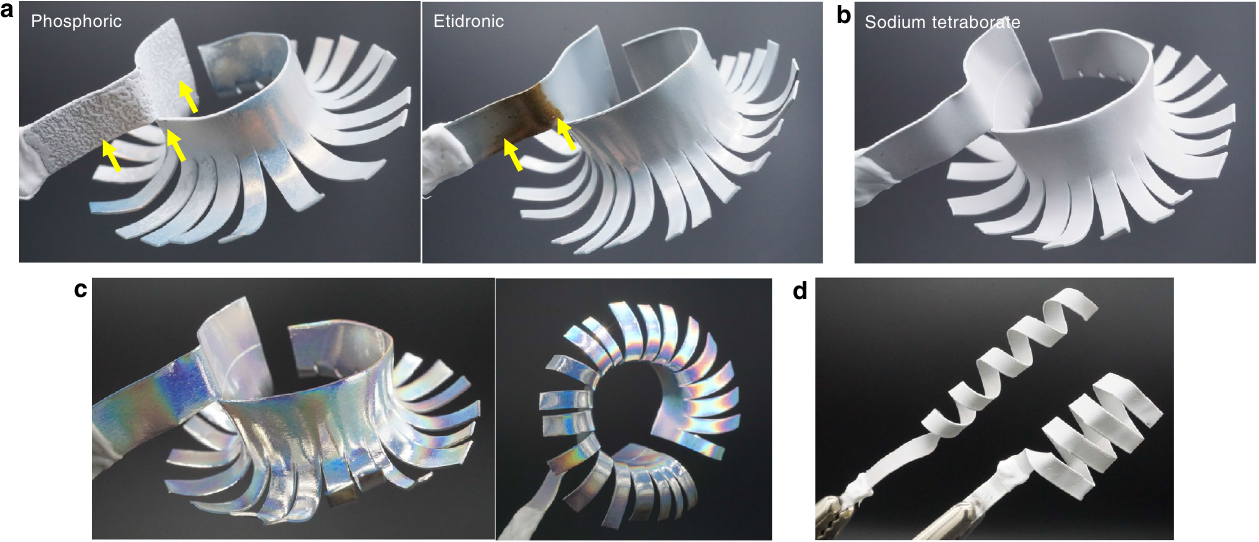
Figure 3. Fabrication of ordered porous AAO structures on complicated three-dimensional Al substrates. ( a ) Surface appearances of flower-shaped three-dimensional Al specimens anodized in 0.3 M phosphoric acid at 273 K and 195 V and 1.0 M etidronic acid at 303 K and 205 V. Nonuniform porous AAO films with an uneven morphology and a brown hue were partially formed on the Al surface. ( b ) Appearance of the uniform porous AAO film formed over the whole flower-shaped Al surface by anodizing in a 0.5 M sodium tetraborate solution at 355 K and 190 V. ( c ) Structural coloration based on the ordered, nanodimpled Al surface after